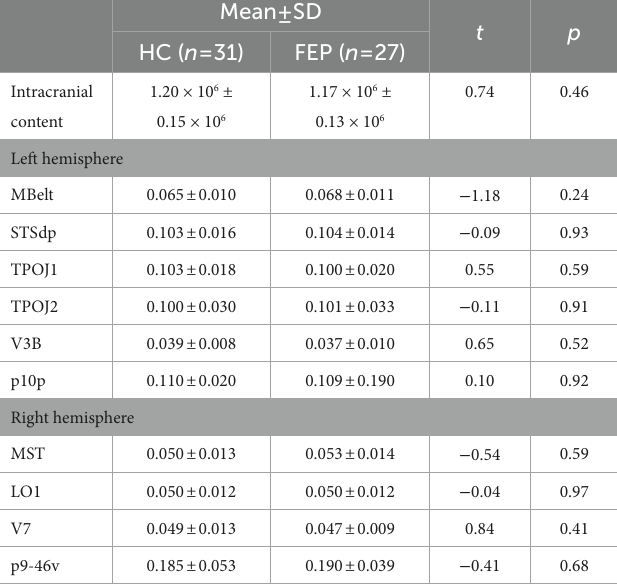
posterior area 9-ventral area